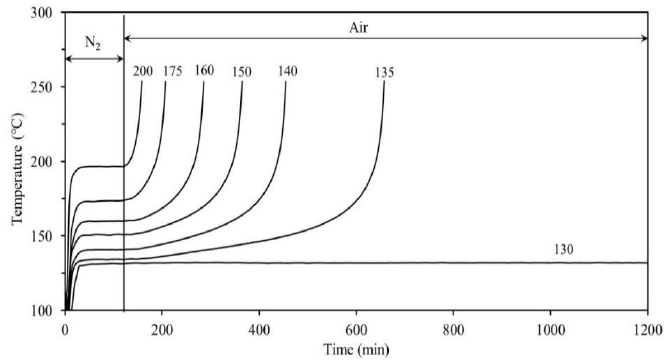
Figure 14. SIT curves for SSSR over the 100 °C to 200 °C range.